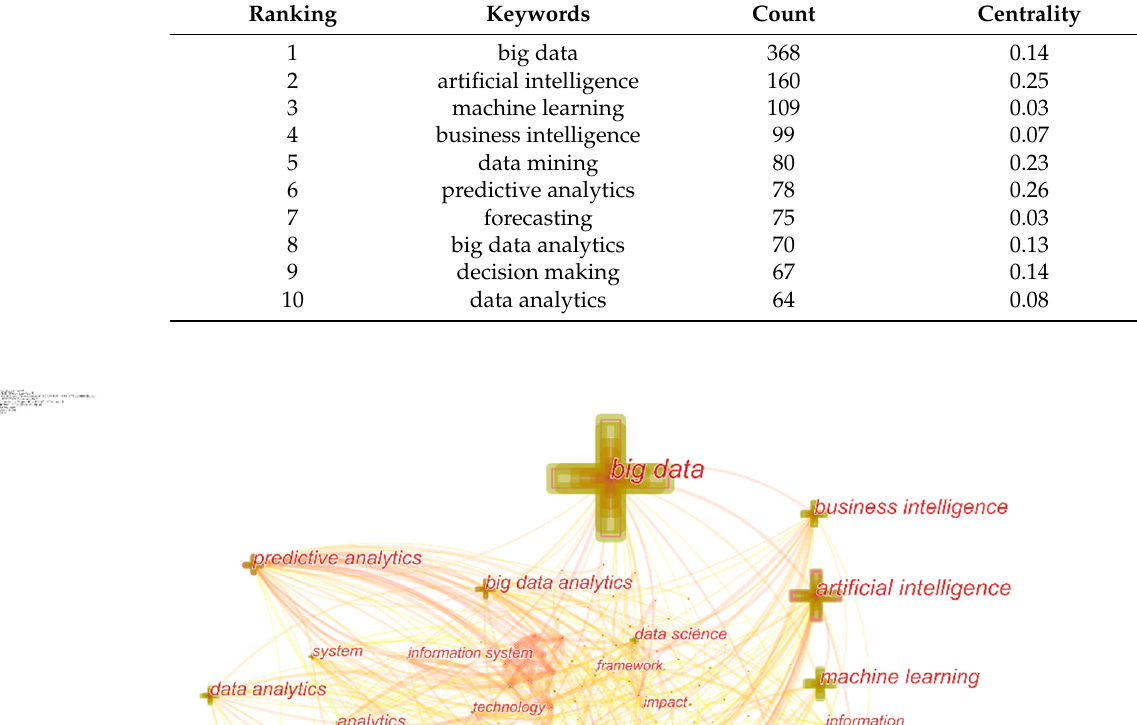
Table 7. Top 10 keywords ranking according to the number of publications involved.